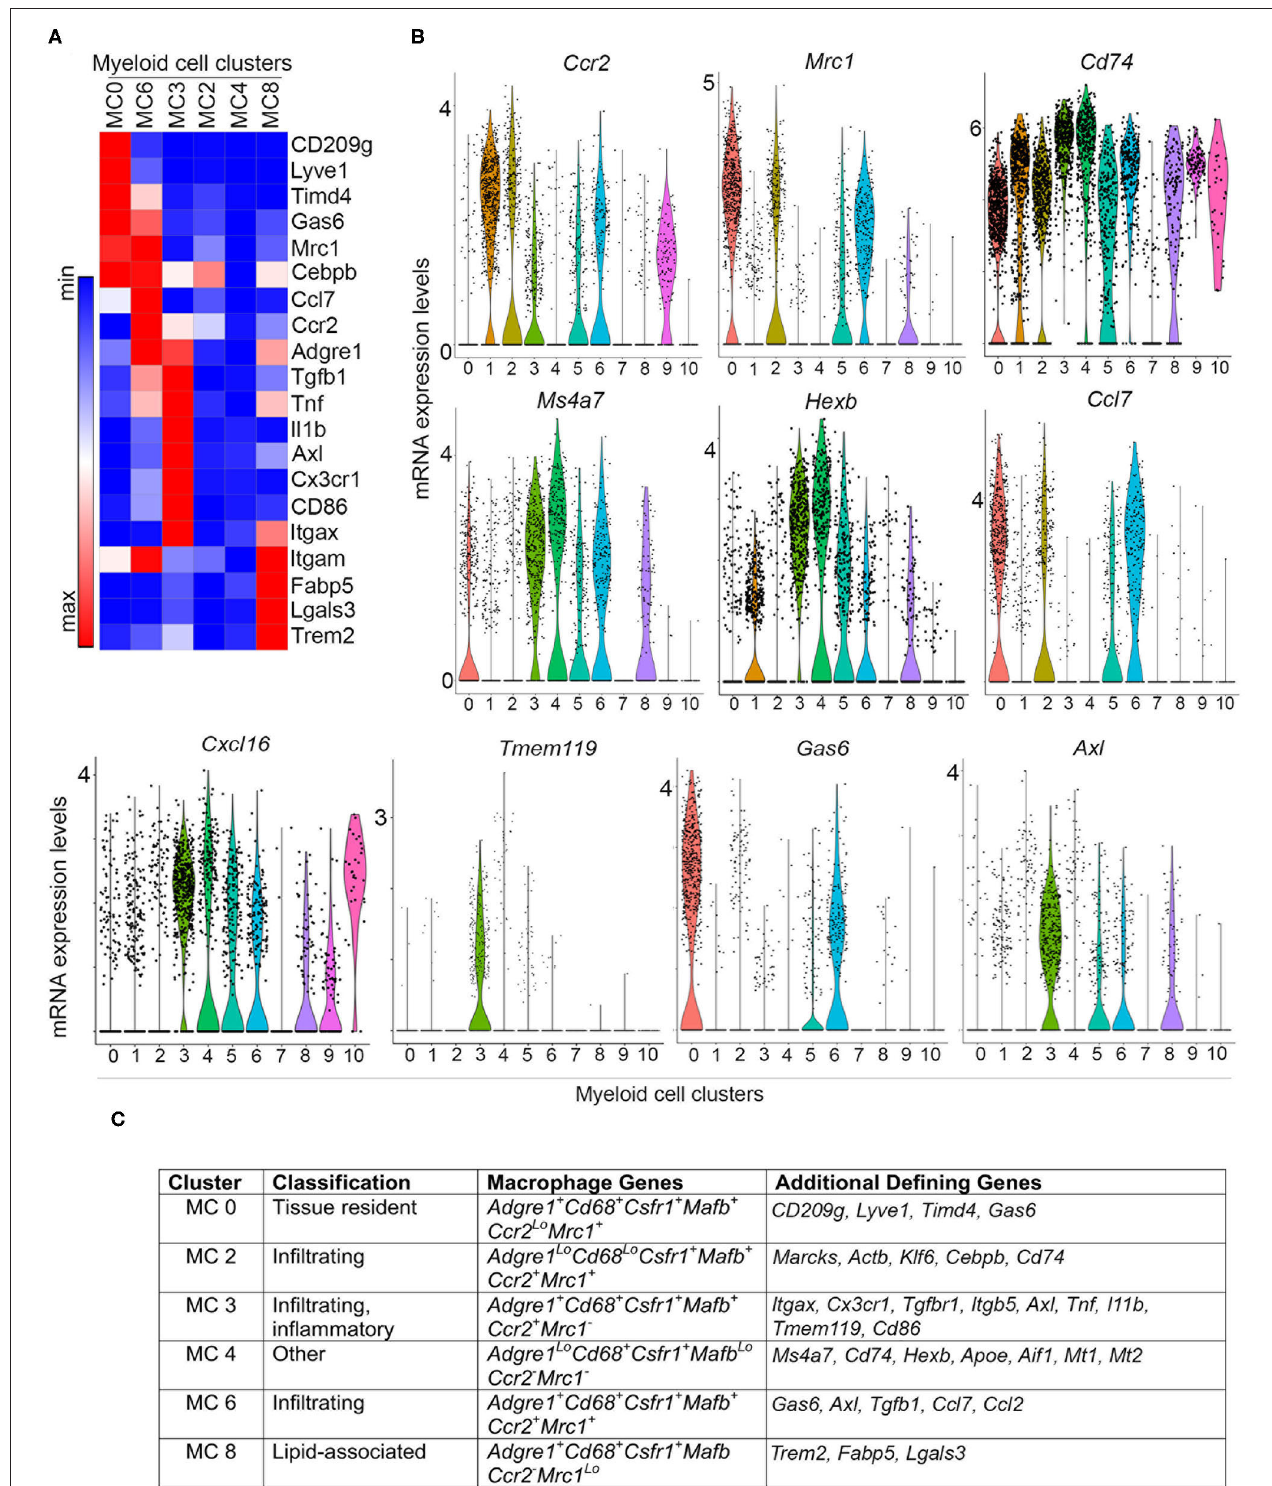
FIGURE 3 | Differential gene expression in macrophage subpopulations. (A) Heatmap depicts differential gene expression of selected genes for macrophage clusters (MC 0, 2, 3, 4, 6, and 8). (B) Violin plots demonstrate the expression of selected genes across myeloid cell clusters. (C) Table summarizing the expression of macrophage genes and other defining genes identified by differential gene expression ( Supplementary Figure 2 , Supplementary Table 1 ), and putative classification of each macrophage subpopulation.